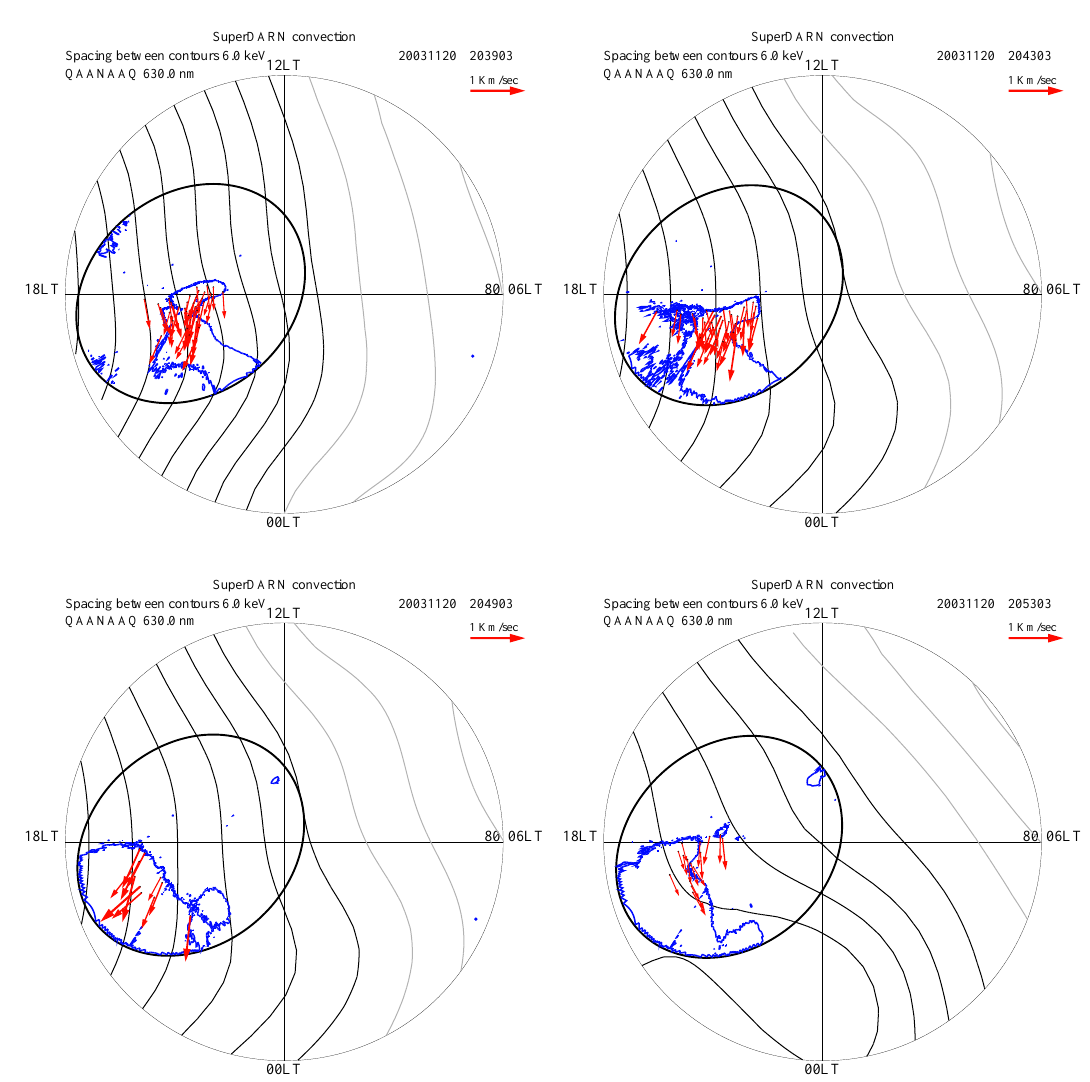
Figure 8. Series of polar cap patches (blue contour) and the patch drift velocity (red vectors) presented in a polar display of CG latitude versus CG local time coordinates. The format of each panel is similar to Fig.